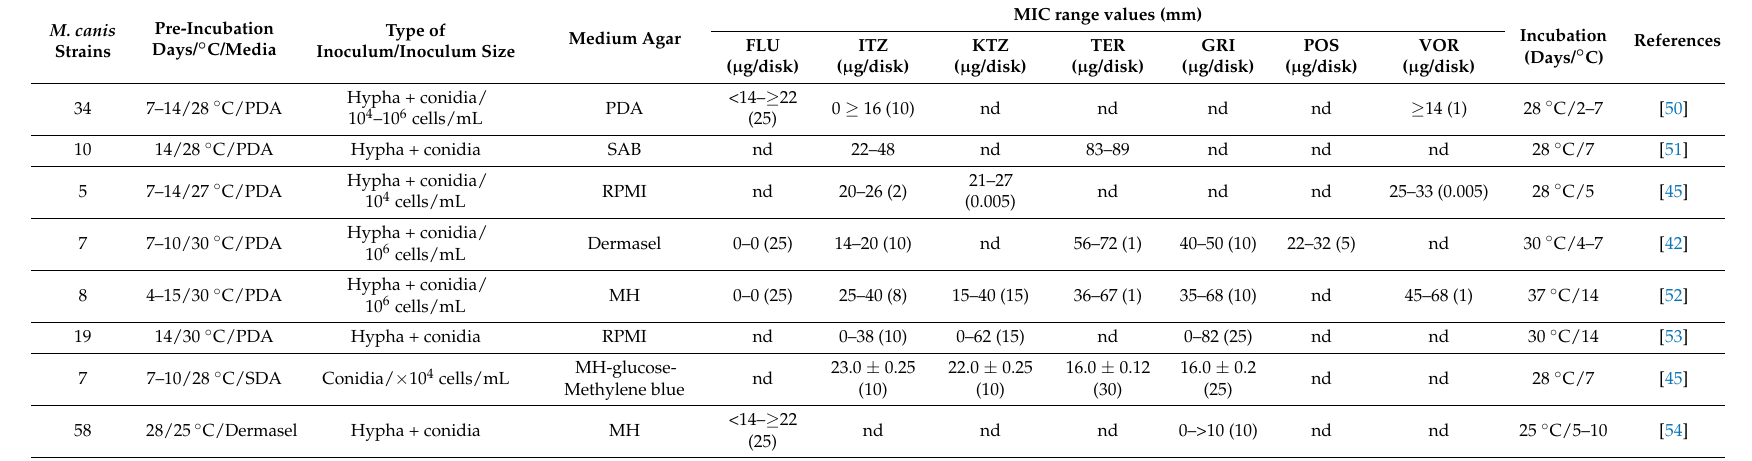
Table 4. Disk diffusion procedures for antifungal susceptibility in Microsporum canis . Inhibition Zone Diameter (mm) for azoles, Griseofulvin and terbinafine were also